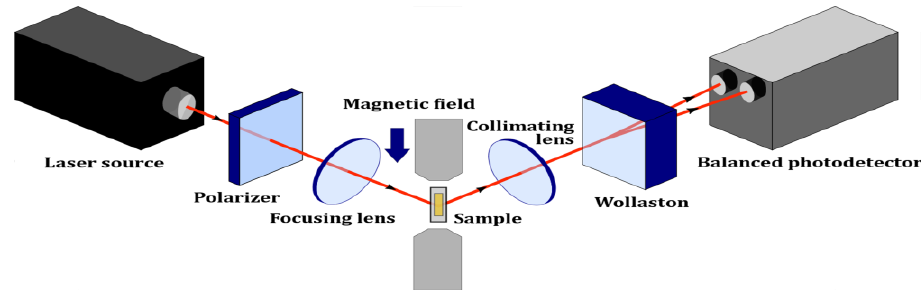
Figure 2. Schematic diagram of the transverse magneto-optical Kerr effect (TMOKE) setup. We also measured the reflectance at a zero field and maximum TMOKE signal, which is proportional field (corresponds to δ ( 1 ) in Equation (10)) for a range of angles of incidence from 10 to 70